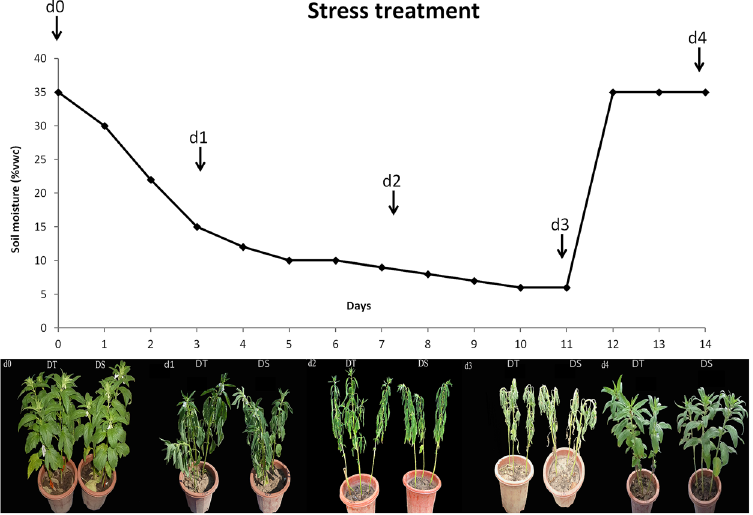
Figure 1. Morphological responses of sensitive (DS) and tolerant (DT) sesame genotypes. The leaves of DS suffer more damage than those of DT during stress. d 0 , d 1 , d 2 , d 3 and d 4 : plants stressed for 0, 3, 7, 11 days and 3 days of recovery after rewatering,